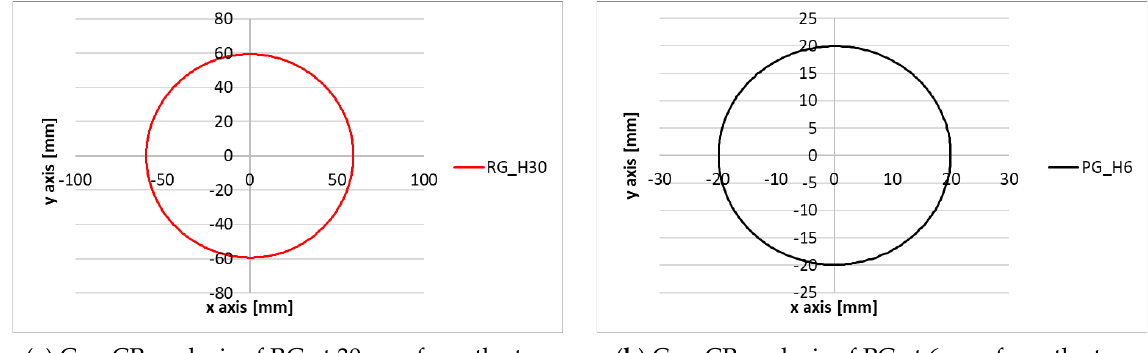
Figure 6. Main results of cup CP analysis. Table 4. Main results of cup CP analysis.